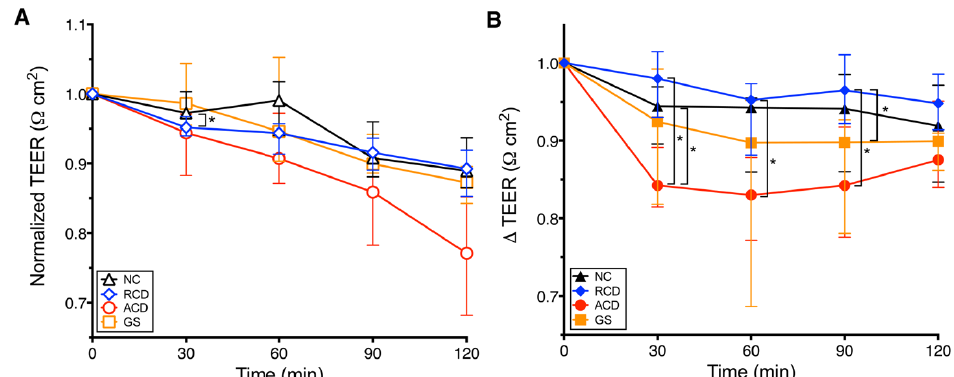
Figure 2. Comparison between groups of gut permeability changes induced by either PT-gliadin or media alone measured as normalized transepithelial electrical resistance changes (∆ TEER) in human intestinal explants. Explants obtained from celiac patients in remission (RCD), non-celiac controls (NC), non-celiac patients with gluten sensitivity (GS), and celiac patients with active disease (ACD). A decrease in TEER indicates increased gut permeability. A. TEER changes of explants exposed to media alone. Explants incubated in media alone demonstrated no significant differences in permeability except between NC (black triangle) and RCD (blue diamond) groups at 30 min. B. TEER of PT-gliadin exposed explants minus TEER of corresponding explants exposed to media alone (∆ TEER). Increases in permeability in explants from the ACD group (red circle) were significantly greater than in explants from the RCD group (blue diamond) at 30, 60 and 90 min, and the NC group (black triangle) at 30 min. Increases in permeability in explants from the GS group (gold square) were significantly greater than in explants from the RCD group at 90 min. There was no significant difference in permeability between explants from the ACD and GS groups, between explants from the RCD and NC groups, or between explants from the NC and GS groups. Symbol denotes the median. Whiskers denote the 25th to 75th percentile. * p < 0.05.